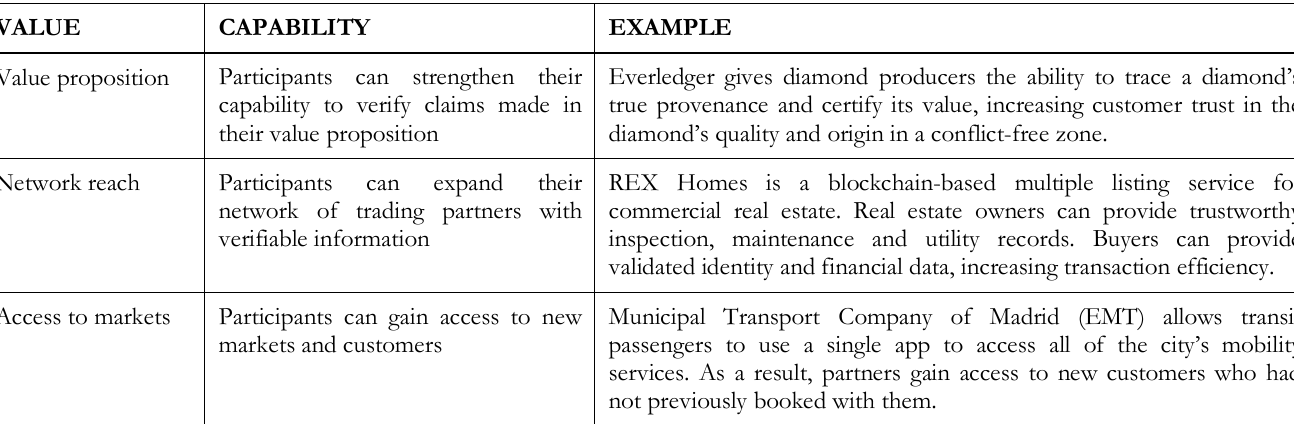
Table 1: Blockchain-Based Strategic Capabilities Framework Build upon existing capabilities – Consortium participants can strengthen their existing